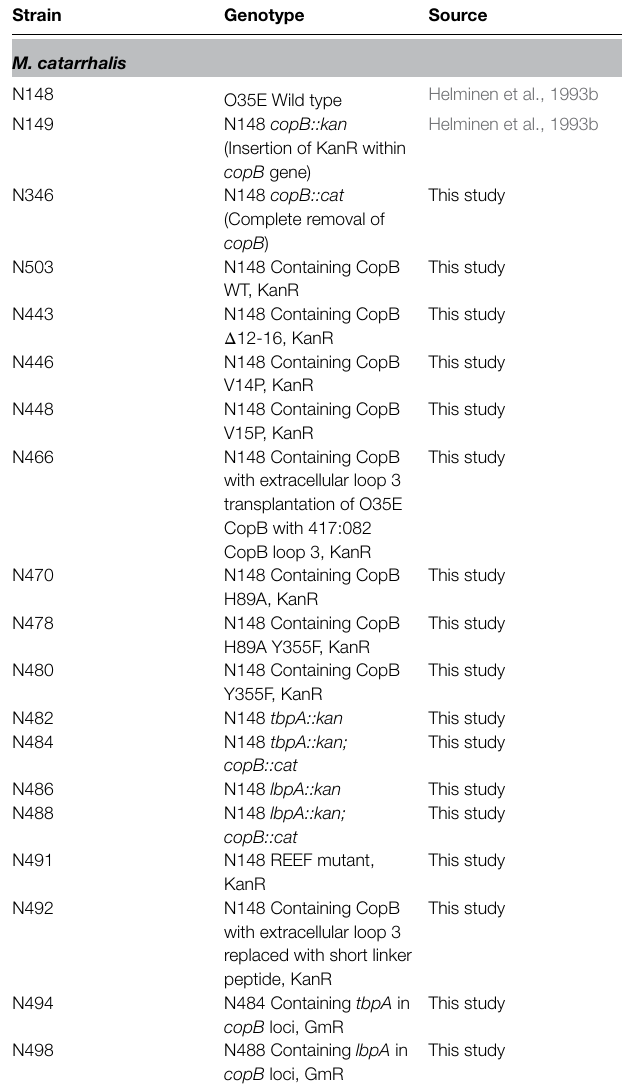
TABLE 1 | List of the bacterial strains in this